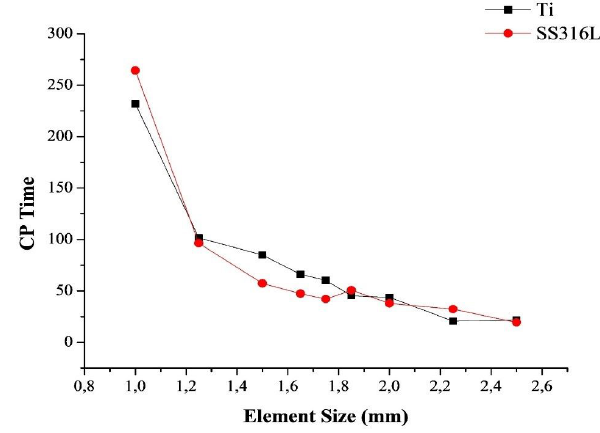
Figure 9: Graph of relationship between element size and